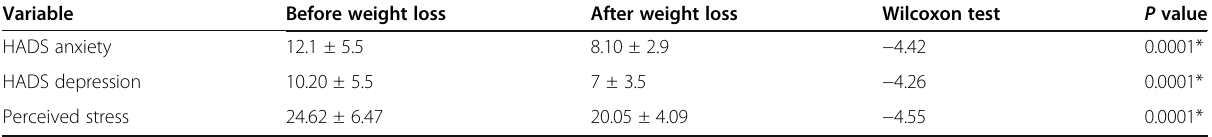
Table 1 Anxiety, depression, and perceived stress scores before and after weight loss